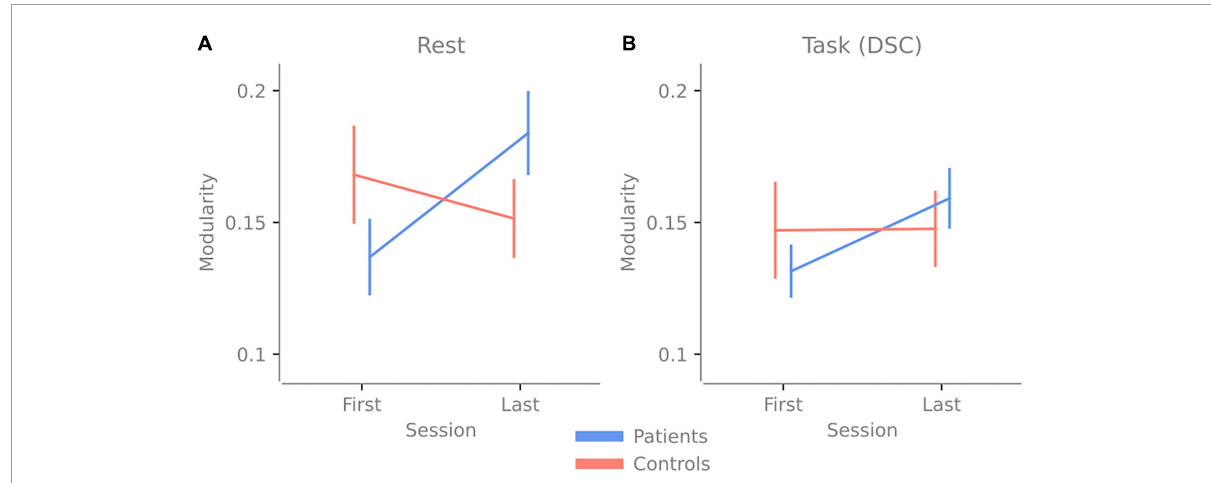
FIGURE3 Change in modularity over 2.5 h of cognitive activity. Panel (A) shows the change in modularity between the first and last resting-state session. (B) The change in modularity during the first and last Digit Symbol Coding (DSC) task was done at the experiment’s beginning and end. Error bars indicate the standard error of the